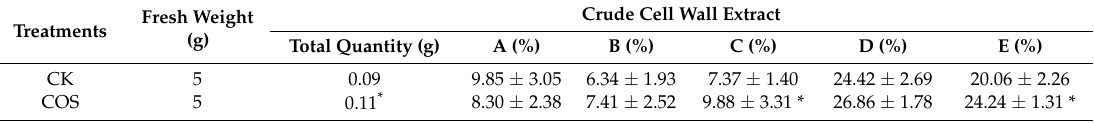
Table 1. Effect of COS pre-harvest treatment on strawberry fruit cell wall composition.